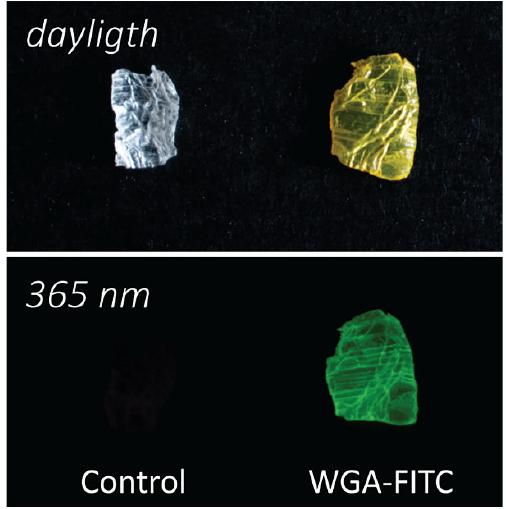
Figure 1. Camera images of the matrices. Camera picture of a chitin sample (control, left ) and a WGA-FITC treated chitin sample ( right ) viewed in daylight ( top ) and under a UV lamp (365 nm; bottom ), each sample is about 5 mm large.